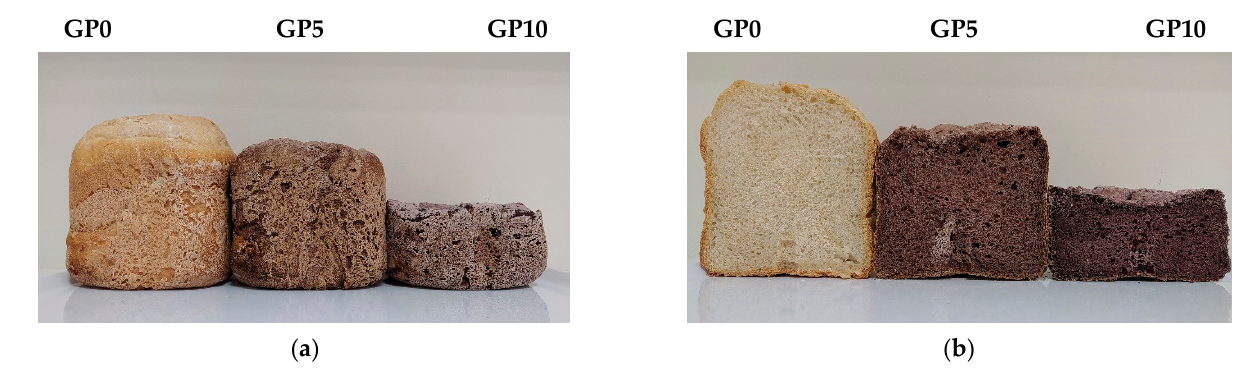
Figure 1. ( a ) Crust side of bread samples; ( b ) crumb side of bread samples. Control bread (GP0) and bread fortified with grape pomace powder (GP5 and GP10).